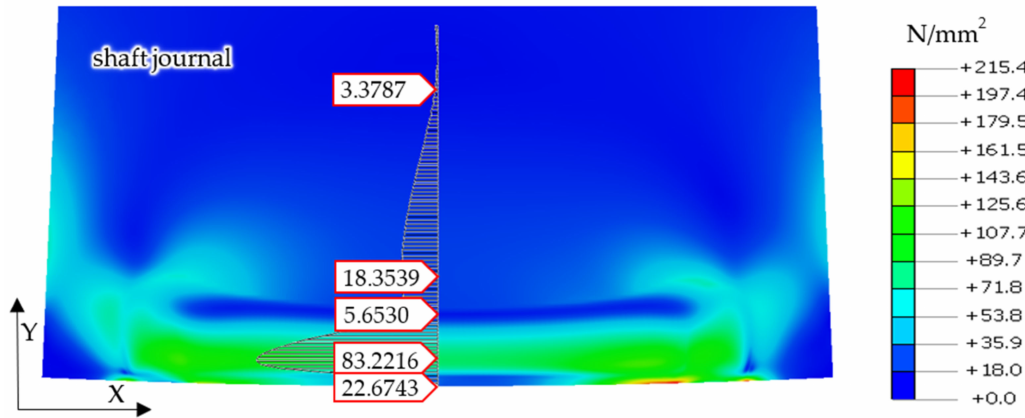
Figure 11. Distribution of permanent stress values in the surface layer of the steel shaft journal, not burdened with outline irregularities, after the outline has been turned over the steel supporting roller.